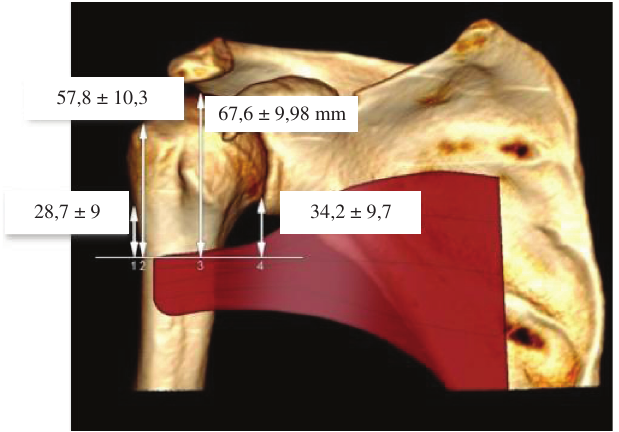
Figure 9. PM-change of curvature distance (yellow) was almost equal to PM-anatomical neck distance (green) (ratio = 0.9).